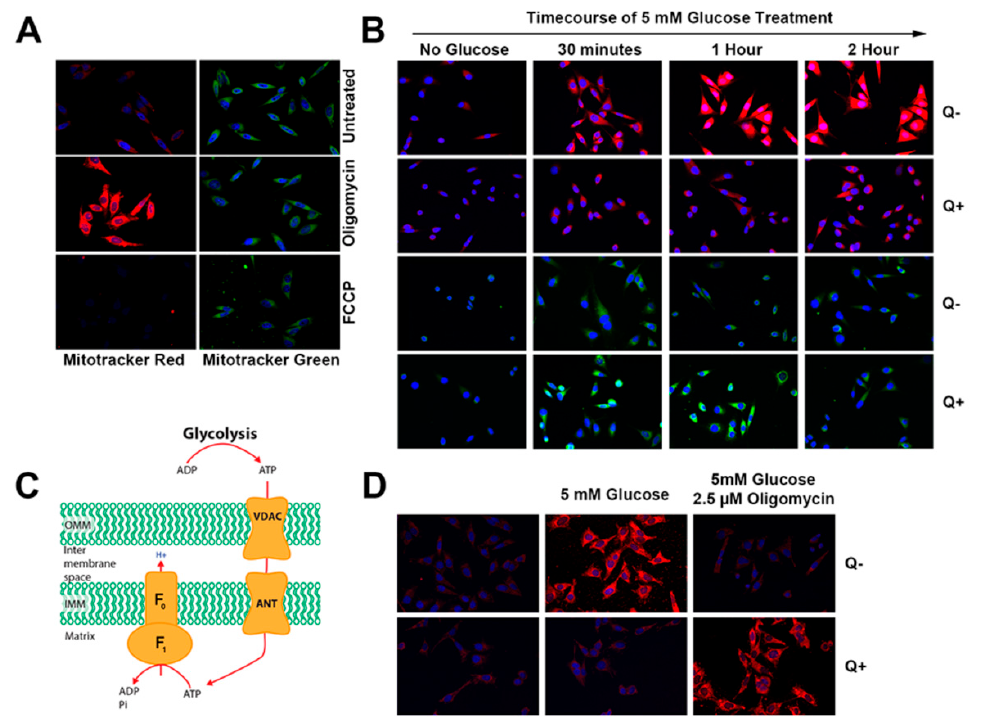
Figure 4. The F 1 F O ATP synthase operates in reverse under queuine deficient conditions. ( A ) Cells were cultured in DMEM-FBS medium on cover slips, treated with 2.5 μ M oligomycin or 5 μ M FCCP and concurrently stained with Mitotracker Red CMXRos (50 nM) and Mitotracker Green (40 nM) before being fixed, permeabilized, and stained with DAPI dye. ( B ) Galactose adapted HeLa cells, cultured in the absence or presence of 1 μ M queuine, were administered 5 mM glucose for the time durations shown, and concurrently with Mitotracker dye (for the last 15 min) prior to fixation. ( C ) The ATP synthase (complex V) consists of two functional domains, F 1 and F O . The F O domain facilitates the passage of protons from the intermembrane space to the matrix transferring the protomotive energy to F 1 , where ADP is phosphorylated to ATP. Normal respiring mitochondria favor ATP synthesis due to a high membrane potential, however, when the potential falls below a threshold, the F 1 F O ATP synthase can operate in reverse to hydrolyse ATP and pump protons into the intermembrane space. ( D ) Galactose adapted HeLa cells were cultured in the absence or presence of 1 μ M queuine. Glucose (5 mM) was administered to the cells for 15 min and subsequently, oligomycin (2.5 μ M) and Mitotracker RedCMXRos were added for a further 15 min before fixation and imaging.